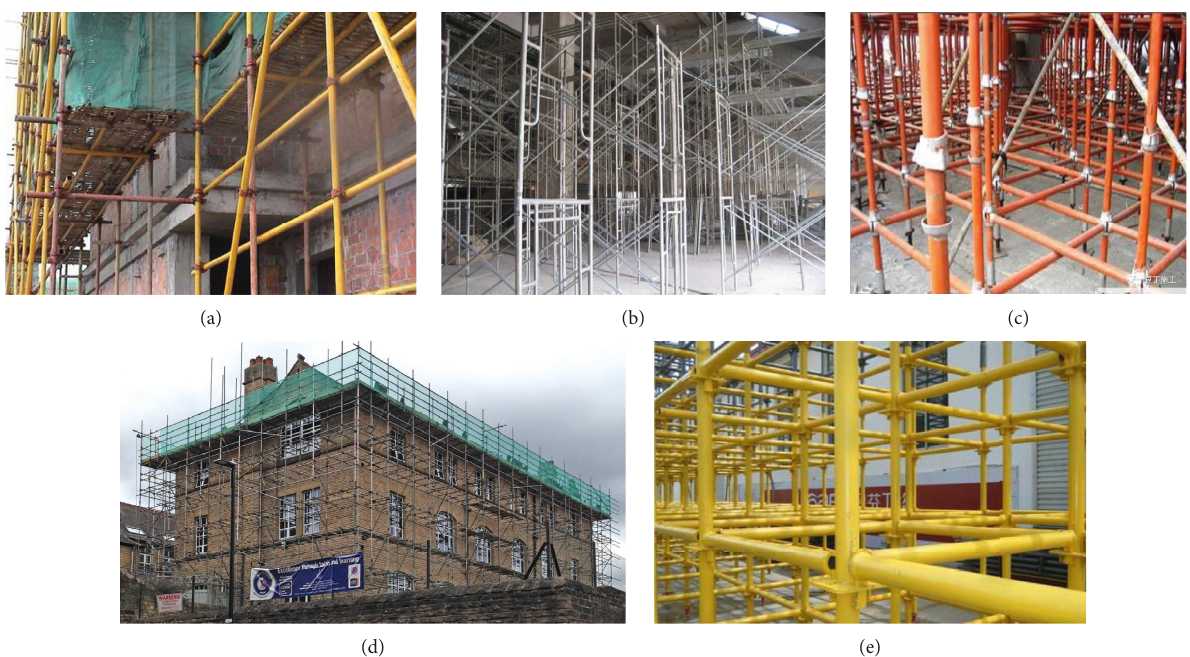
Figure 1: Pictures of different types of scaffolds. (a) Fastener scaffold. (b) Door-type scaffold. (c) Cuplock-type scaffold. (d) Access scaffold. (e) Inserting-type